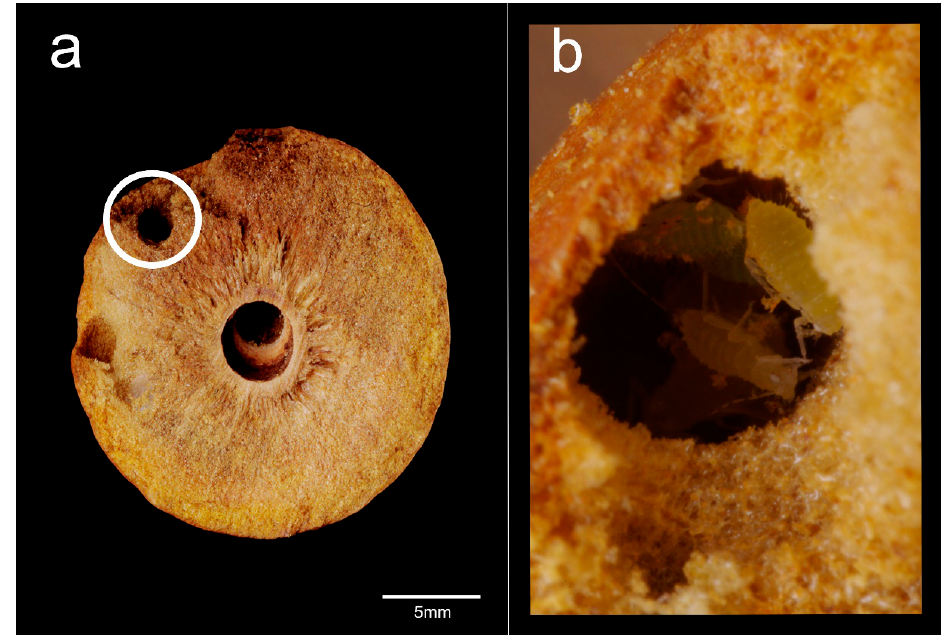
Figure 9. ( a ) Section of a gall colonized by a single queen of C. scutellaris ; the circle highlights the aphid chamber; ( b ) aphids present inside the chamber excavated by the queen.